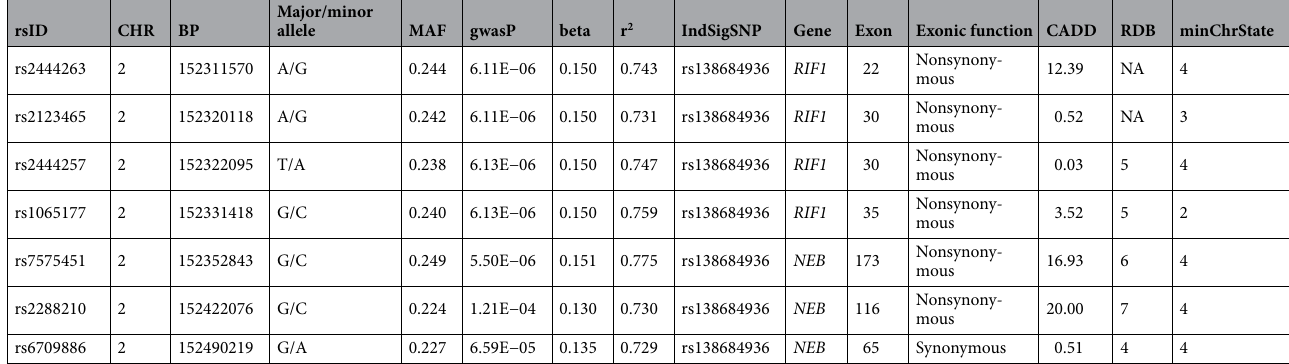
These SNPs were associated with multiple traits belong to the metabolic and immunological domains (Supple- mentary Table S7). Generally, the pleiotropic effects were caused by one SNP associated with multiple correlated phenotypes. For example, the rs2444263 was significantly associated with estimated glomerular filtration rate (eGFR) and impedance of arm, age at menopause, and impedance of whole body, and trunk fat percentage, etc. (Bonferroni corrected p < 0.05, Supplementary Table S7). Genetic correlations were also found between the mul- tiple traits associated with our top SNPs (Supplementary Fig. S4).